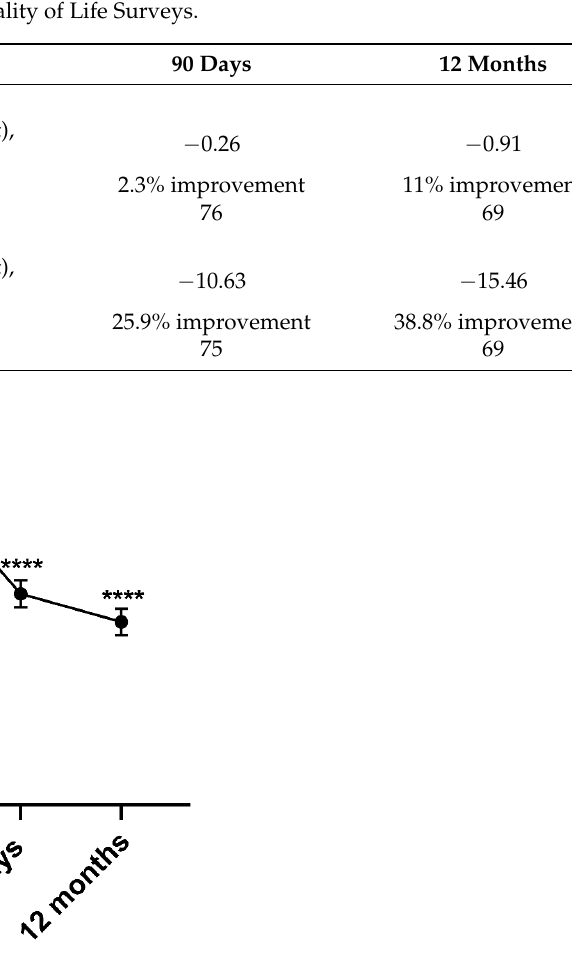
Figure 3. HerQLes Summary Scores Before and After Ventral Hernia Repair. Patient HerQLes sum- mary scores before surgery (Baseline), 30 days post-op, 90 days post-op, and 12 months post-op. Lower HerQLes summary score indicates better QOL. n = 63. Values are mean ± SE. **** p <